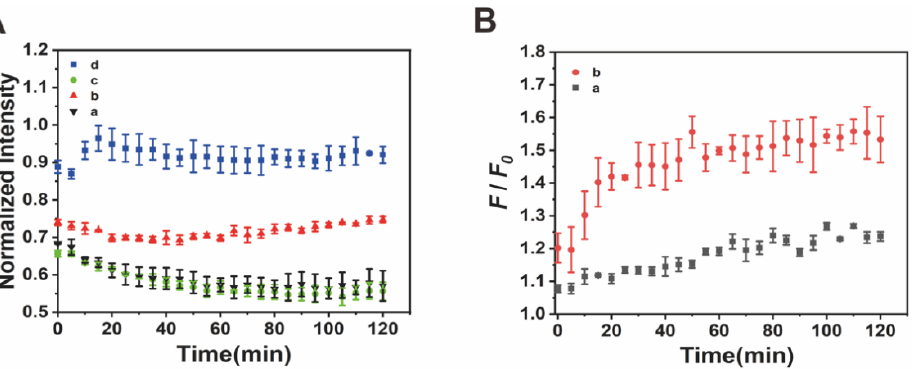
Figure 2. Reaction kinetics of the substrate-cleaving performance of DNAzyme amplifier. ( A ) Time- dependent fluorescence signal changes of different reaction systems: (a) substrate + Mn 2+ ; (b) substrate + DNAzyme + Mn 2+ ; (c) substrate + Dzm/blocker + Mn 2+ ; (d) substrate + Dzm/blocker + Mn 2+ + miR-10b. ( B ) F / F 0 signal changes of different reaction systems. (a) Single DNAzyme catalysis cleaving performance with DNAzyme. (b) DNAzyme cycle amplifier cleaving performance with miR-10b. F 0 and F represent the fluorescence intensity in the absence and presence of target miR-10b, respectively. Error bars represent the standard deviation of three determinations. Experimental con- ditions: substrate concentration of 25 nM, DNAzyme concentration of 25 nM, blocker concentration of 30 nM, Mn 2+ concentration of 750 µ M, miR-10b concentration of 50 nM, 25 mM Tris-HCl buffer (containing 137 mM NaCl, pH 7.0).